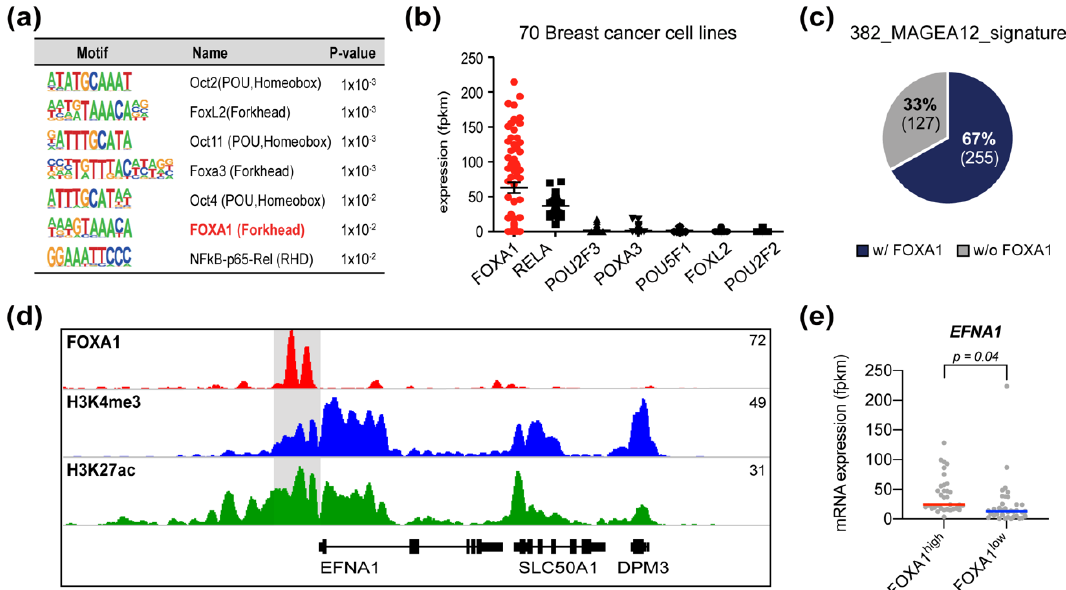
Figure 6. FOXA1 is a candidate transcription factor in the MAGEA12 pathway. ( a ) Motif analysis of the promoter regions of the 382 MAGEA12 signature genes. ( b ) RNA-seq data of 70 breast cancer cell lines showing the expression levels of the candidate transcription factors. ( c ) Pie chart depicting the frequency of the 382 MAGEA12 signature genes with and without FOXA1-binding motifs. ( d ) IGV genome browser snapshot showing FOXA1, H3K4me3, and H3K27ac ChIP-seq data at the EFNA1 locus. ( e ) Expression of EFNA1 in the 70 breast cancer cell lines that were divided into those that expressed FOXA1 at high or low levels.